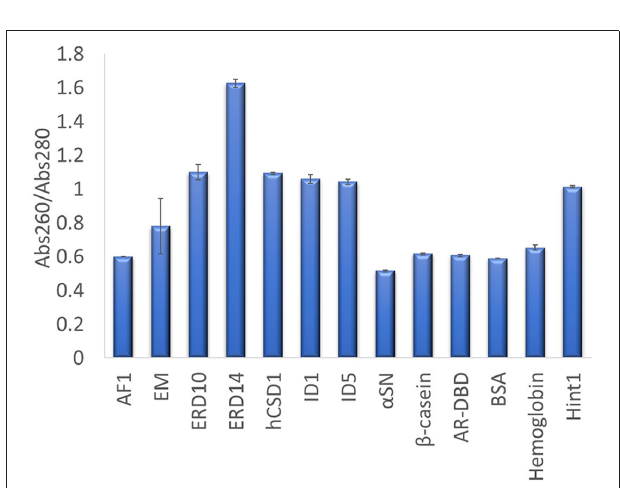
FIGURE 4 | Abs260/Abs280 ratio for each protein determined on a Nanodrop. UV absorbance of each protein was measured in triplicate at 260 and 280nm, to derive their Abs260/Abs280 ratio. The average value is shown and the error bars represent the standard deviation for each protein sample. A high ratio of ERD14 suggests an inherent nucleic acid